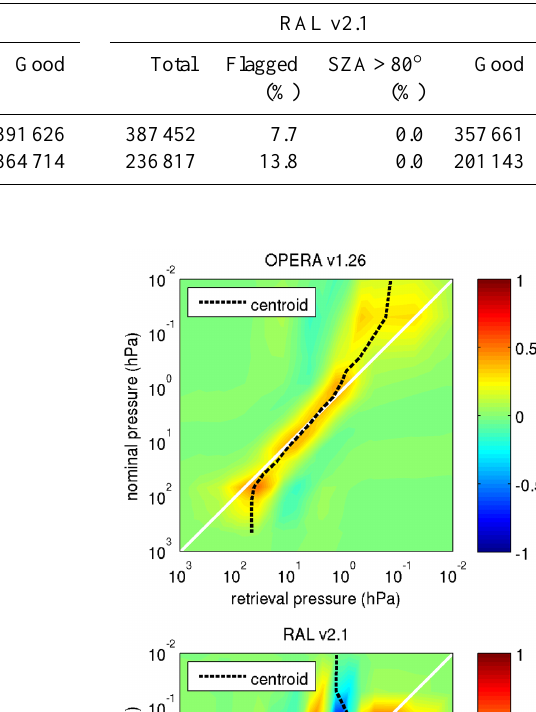
Table 2. Numbers of profiles and screening (profiles omitted from future analysis) percentages for both GOME-2 (2008) nadir RR data sets.